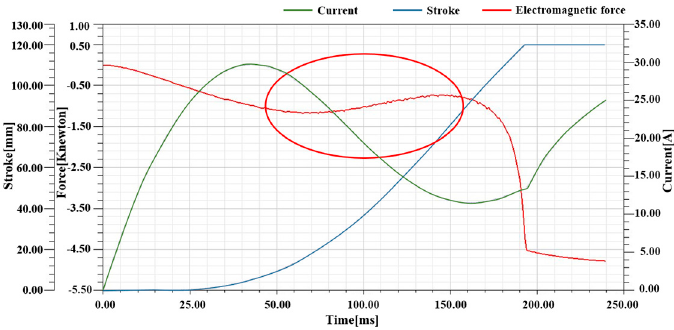
Figure 12. Data of operating characteristics obtained from FEM analysis.